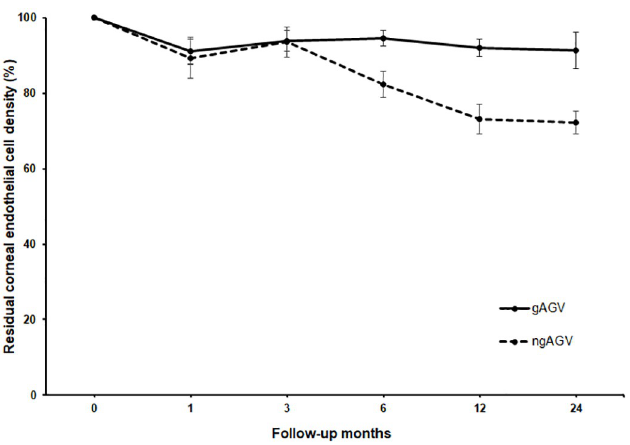
Fig 2. Changes in residual corneal endothelial cell density (ECD) over time after Ahmed glaucoma valve (AGV) implantation in the guided AGV and non-guided AGV groups. Dots represent mean percentages of remaining ECD in comparison with the preoperative ECD starting at 100%. Standard error bars are given at 1, 3, 6, 12, and 24